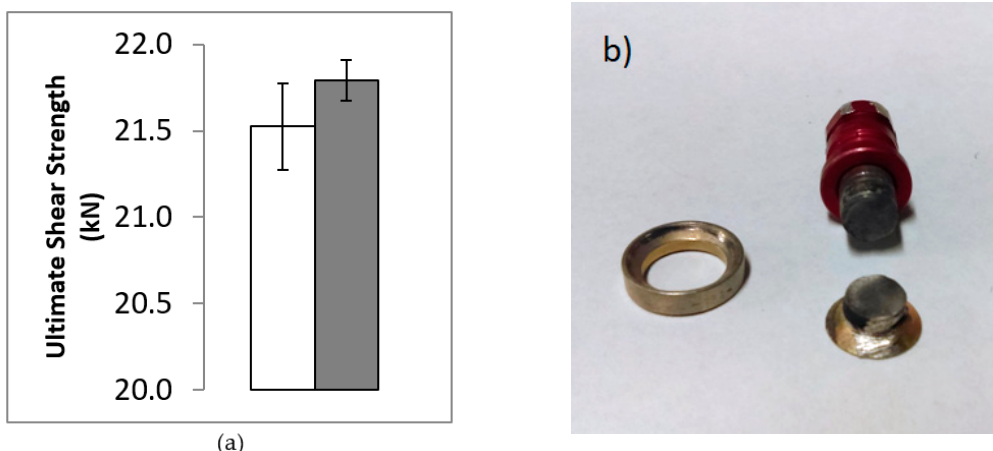
Figure 5. ( a ) average static shear strength of fastener pins: Baseline open symbol, collar replacement filled symbol (error bars represent ± 1 standard deviation); and ( b ) shear failure of fastener pin (washer shown at left).